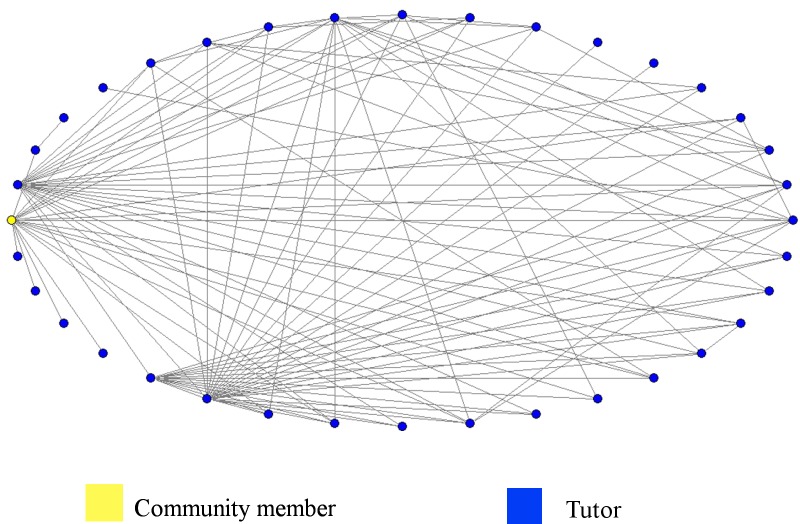
Network of Cluster ID-3 (Louvain method) After the Shrinking Operation.